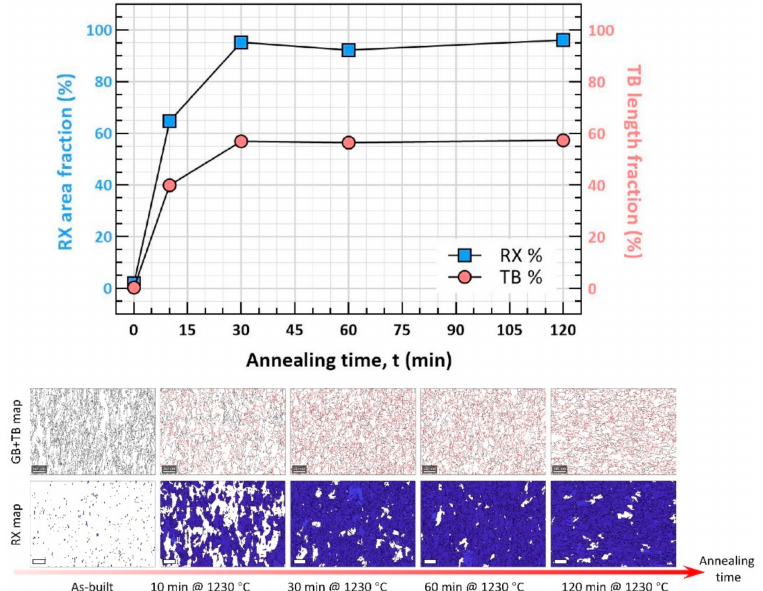
Figure A4. The twin boundary (TB) and recrystallization (RX) fraction evolution as a function of annealing time at 1230 ◦ C, indicating a combination of rapid RX and TB formation processes. The EBSD scans cover an area od 870 µ m × 1266 µ m with a 2- µ m step size. In the GB + TB maps, the grain boundaries (GB) are plotted in black lines, while TBs are plotted in red lines. In the RX maps, RXed grains are colored in blue. All the scale bars are 125 µ